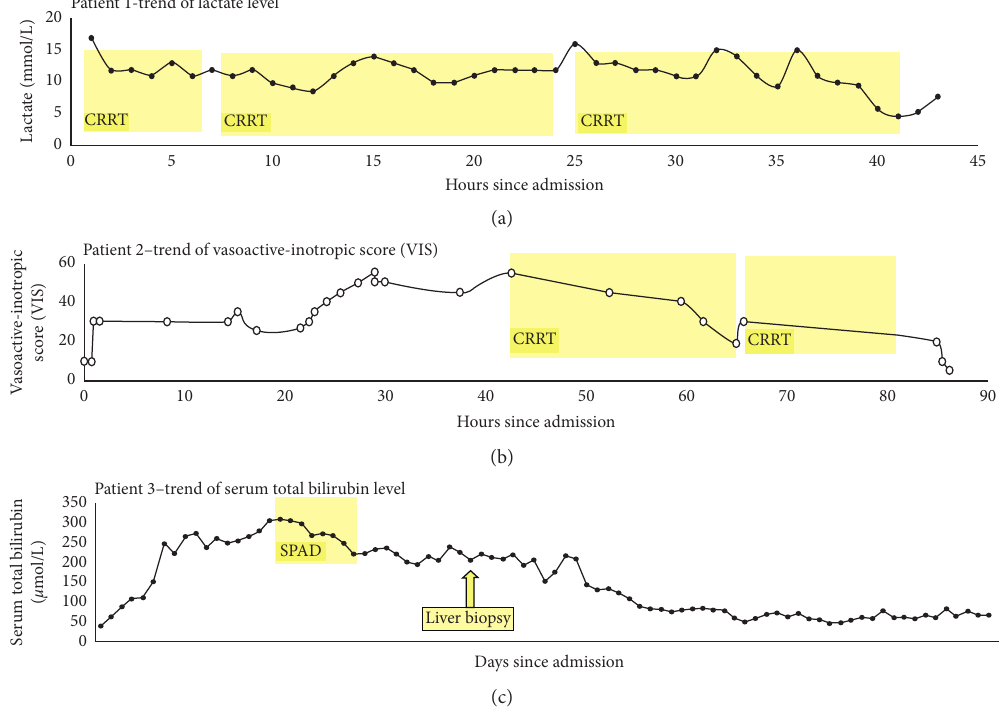
Figure 1: The effectiveness of continuous renal replacement therapy (CRRT) of the three patients.